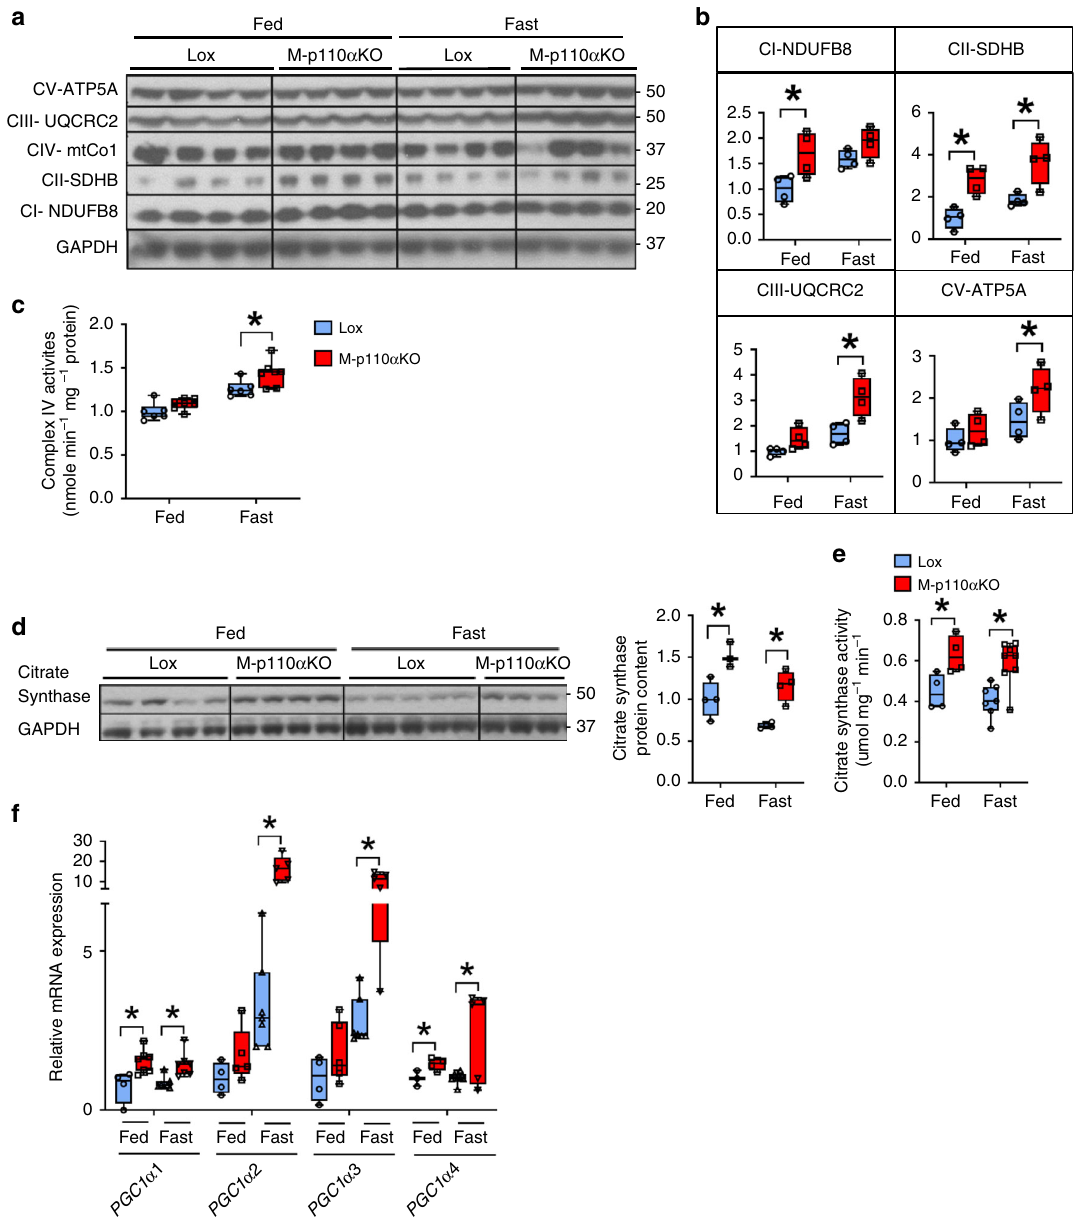
Fig. 4 Increased mitochondrial biogenesis and enhanced expressions of PGC1 α isoforms. a , b Western blot ( a ) and densitometric analysis ( b ) of proteins from the OXPHOS pathway in TA muscles of M-p110 α KO and controls fasted for 24 h or randomly fed. c Complex IV activity in mitochondria isolated from skeletal muscle of M-p110 α KO and controls in fed or 24 h fasted conditions (ctrl, n = 6; KO, n = 7). d Citrate synthase protein content from TA muscles of M-p110 α KO and controls fasted for 24 h or randomly fed as measured by western blot analysis. e Citrate synthase activity from gastrocnemius of M- p110 α KO and control mice fasted for 24h or randomly fed (ctrl, n = 4; KO, n = 9). f mRNA expression of PGC1 α isoforms in TA muscles of M-p110 α KO and control mice fasted for 24 h or randomly fed (ctrl, n = 4; KO, n = 9). All mice were 3- to 4-month old. * P < 0.05 by Student ’ s t test. Box plots visualize the fi ve-number summary of the data set (minimum, lower quartile, median, upper quartile, and maximum). NDUFB8 ubiquinone oxidoreductase subunit B8, SDHB succinate dehydrogenase subunit B, UQCRC2 ubiquinol cytochrome c reductase core protein 2, ATP5A ATP synthase α oxygen and reactive nitrogen species (ROS/RNS) levels in muscle (Fig. 5f, g) and intramyo fi brillar (Supplementary Fig. 4f, g) of M-p110 α KO in both fed and fasted states (Fig. 5e). This was mitochondria, indicating higher free radical release in muscle of con fi rmed by in vivo fl uorescence microscopy, when muscle these mice. This shift in MitoTimer fl uorescence in M-p110 α KO fi bers of living mice were transfected in situ using a gene gun was abolished when the muscle was co-transfected with a delivery approach with a pMitoTimer reporter plasmid, which constitutively active mutant of p110 α (PIK3CA) E545K (Fig. 5g; targets to the mitochondria and irreversibly shifts the fl uores- Supplementary Fig. 4g). Together, these data show elevated cence spectrum from green to red in the presence of ROS 33,34 . mitochondrial oxidative capacity and increased ATP content, Quantitation showed a 45 – 50% increase in red to green accompanied by increased oxidative stress in muscle following fl uorescence ratio in M-p110 α KO in both the subsarcolemmal p110 α deletion.